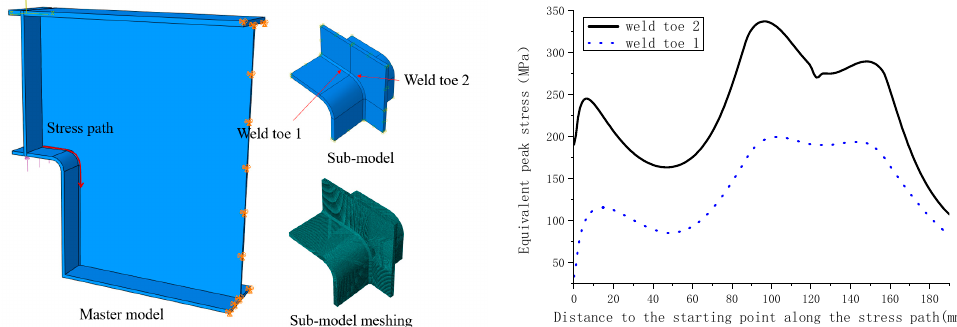
Figure 16. Peak stress analysis model and results for the variable-section supports with R-plates.